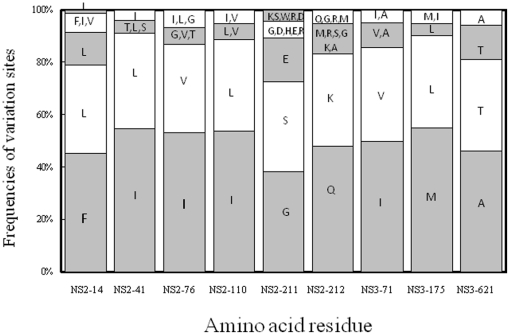
Frequencies of variation sites assessed from Weka.The covariation sites were predicted at the 5′UTR243 nucleotide position and their corresponding amino acid sites in HCV NS2 or NS3. Co-variation sites between the 5′UTR243G (grey) and 5′UTR243A (white) with the corresponding amino acid residues (single-letter code) are shown in accumulative percentage. A frequency >10% for an amino acid residue is presented individually. Possible NS2 co-evolving sites include the 14th, 41st, 76th, 110th, 211th and 212th residues; possible NS3 sites include the 71st 175th and 621st residues.